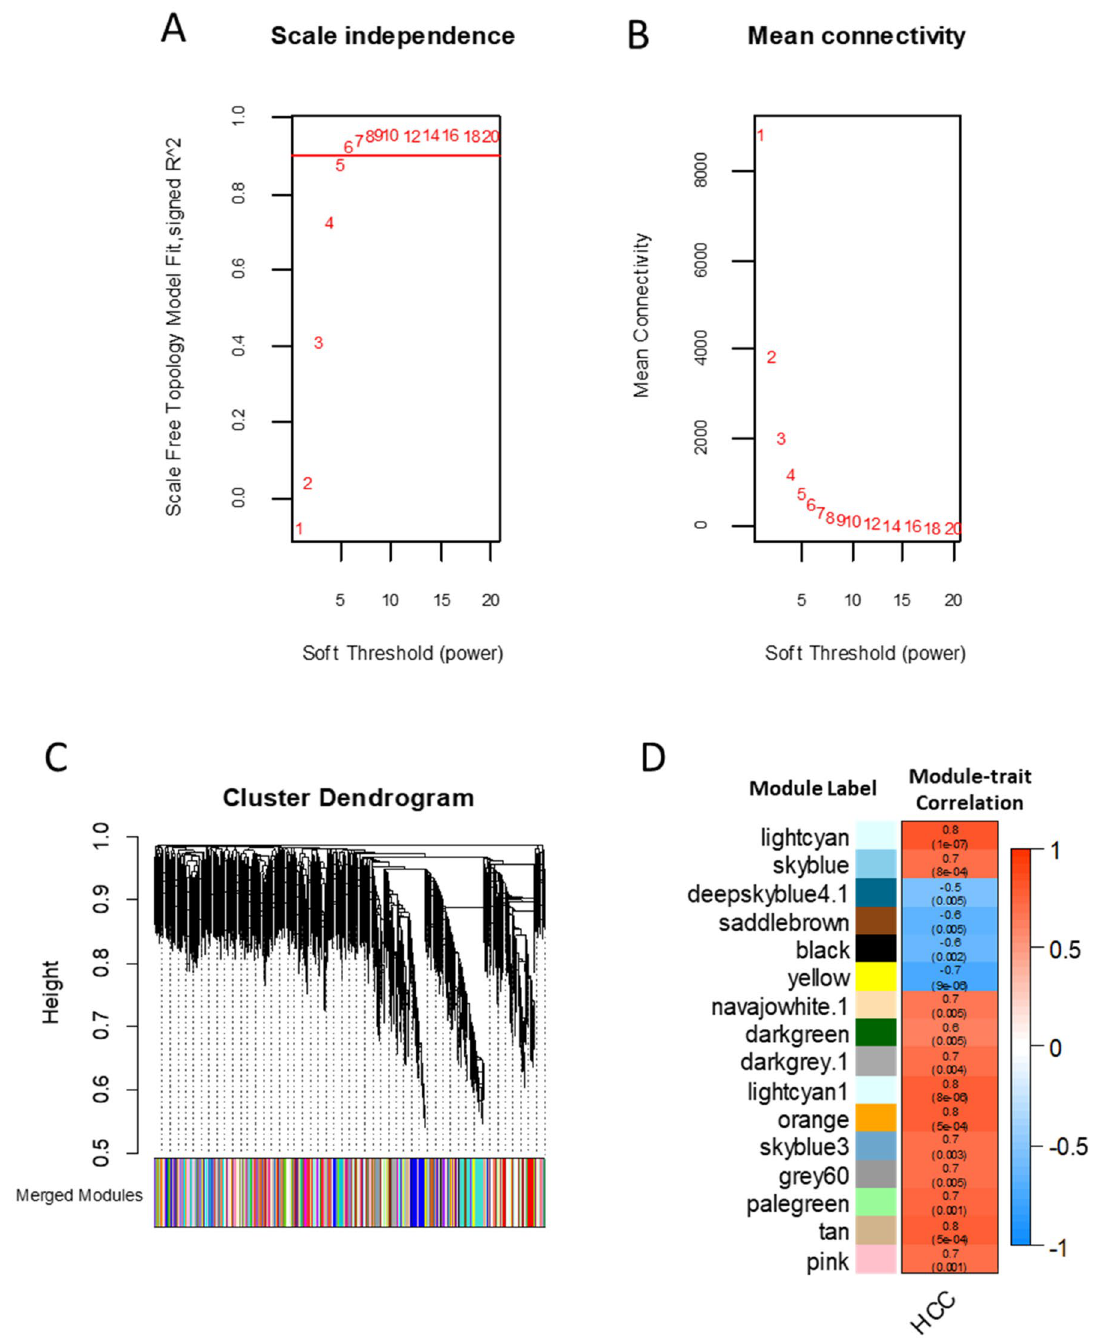
Figure 1. Construction of co-expression networks and identification of HCC-associated modules in C3H mice. ( A ) Relationship of soft threshold and scale-free topology index. We selected 6 as soft thresholding power, which reached R 2 = 0.93. ( B ) Soft thresholding power as a function of connectivity. ( C ) Clustering dendrogram of genes/miRNA and assigned colors of co-expression modules. Total number of co-expression modules: 758; miRNA-containing modules: 318. ( D ) miRNA containing modules significantly associated with HCC. Numbers displayed in each module: top, correlation coefficient with HCC; bottom, p-value. Colors represent the correlation coefficients between the modules and the HCC